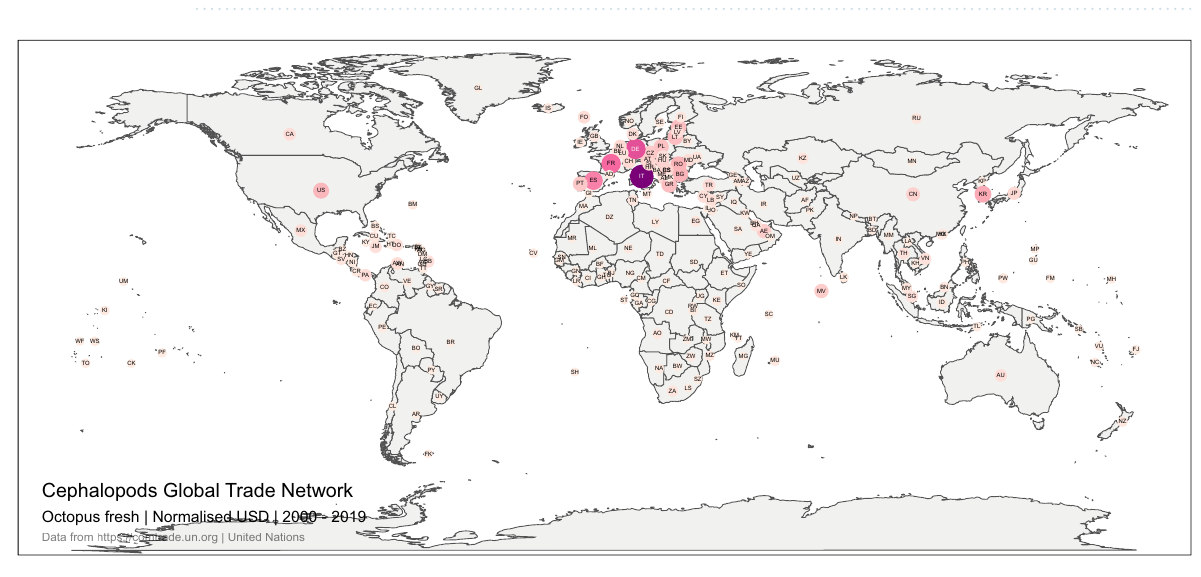
Figure 5. Global trade network for octopus live, fresh or chilled between 1 January 2000, and 31 December 2019 in monetary value (USD). The numbers correspond to the normalised PageRank for the monetary value. Each node represents a trader. The size and colour of the node represent the relative importance of the trader in the network in terms of its PageRank. The figure was created with R 12 (https:// cran.r- proje ct. org) packages: “ggplot2” v.3.2.1 13 (https:// ggplo t2. tidyv erse. org), “ggmap” v.3.0.0 29 (https:// github. com/ dkahle/ ggmap) and “ggraph” v.2.0.0 30 (https:// ggraph. data- imagi nist.